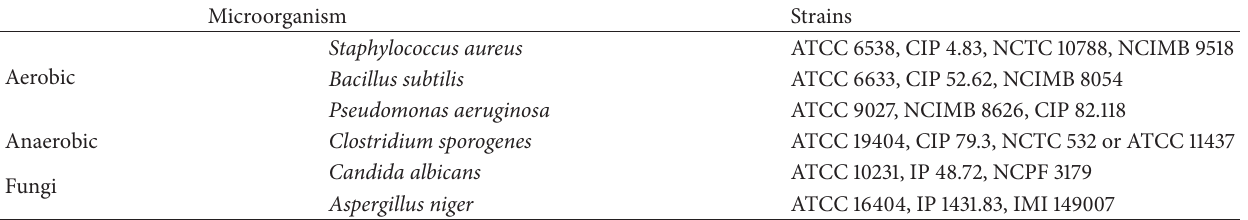
Table 5: Strains of the test microorganisms suitable for use in the growth promotion test and the validation test.